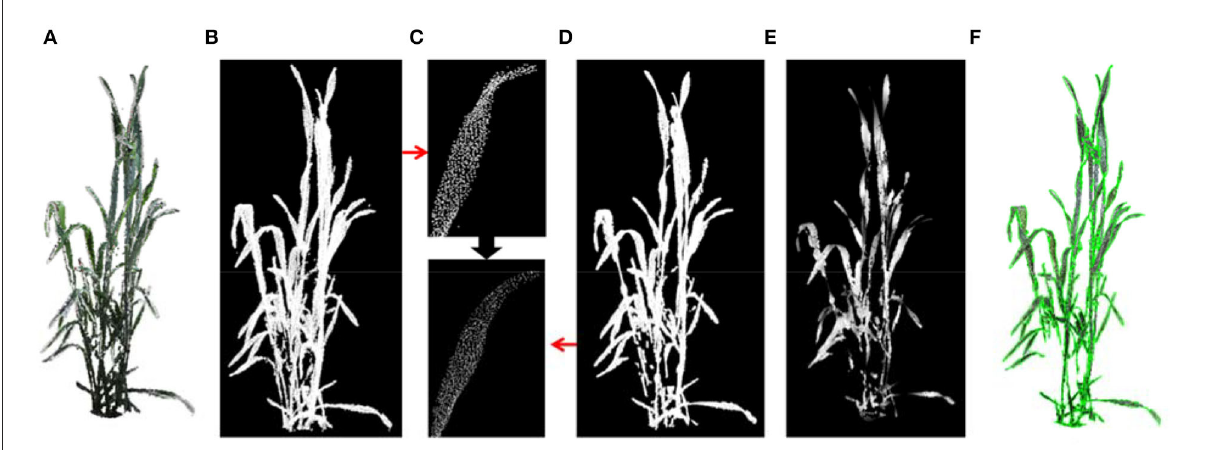
FIGURE6 The leaf area estimation. (A) Wheat shoot point cloud. (B) Down sampled point cloud. (C) A leaf before and after point cloud smoothing. (D) Point cloud of a shoot after smoothing. (E) Triangulated mesh from the point cloud (D) . (F) Merged visualization of generated mesh and original colored point cloud.